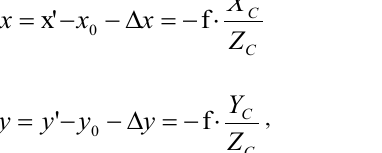
reference system parallel to the photogrammetric system with origin in the image centre; (x 0 , y 0 ) are the coordinates of the principal point (PP) and; Δx and Δy are equations describing